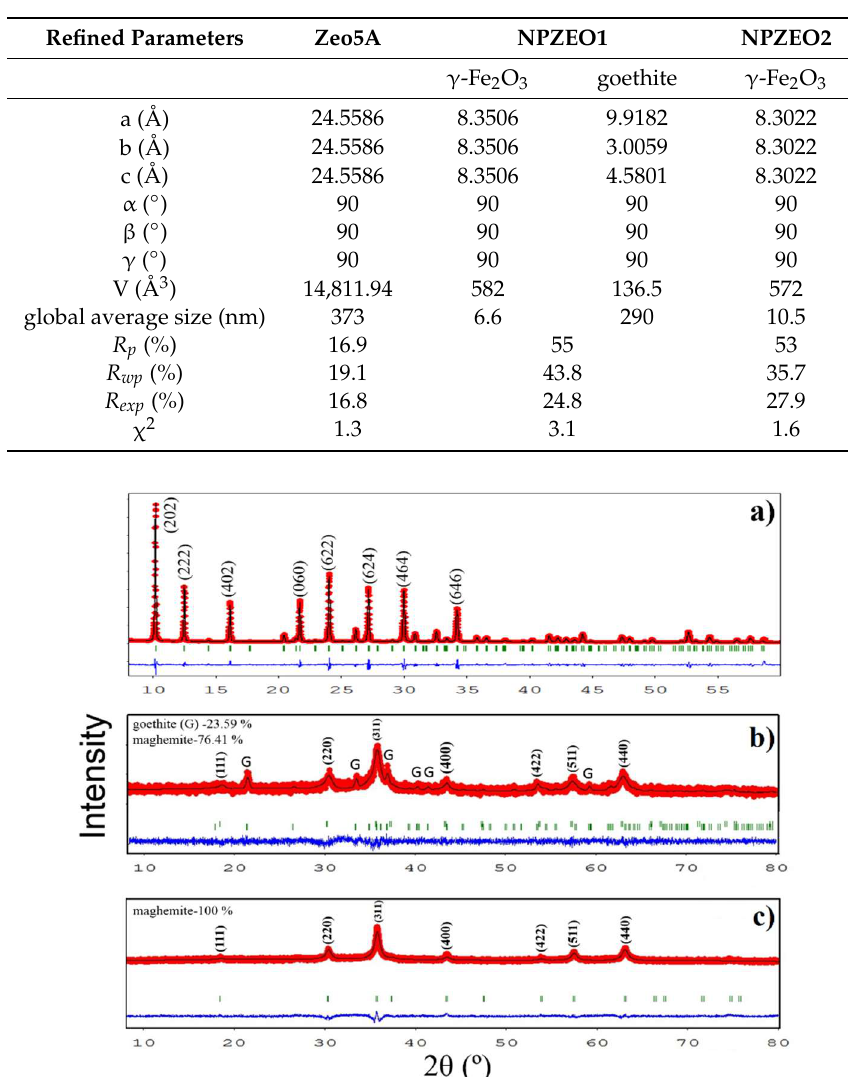
Table 1. Rietveld refinement parameters of zeolite type 5A, NPZEO1, and NPZEO2 samples using the